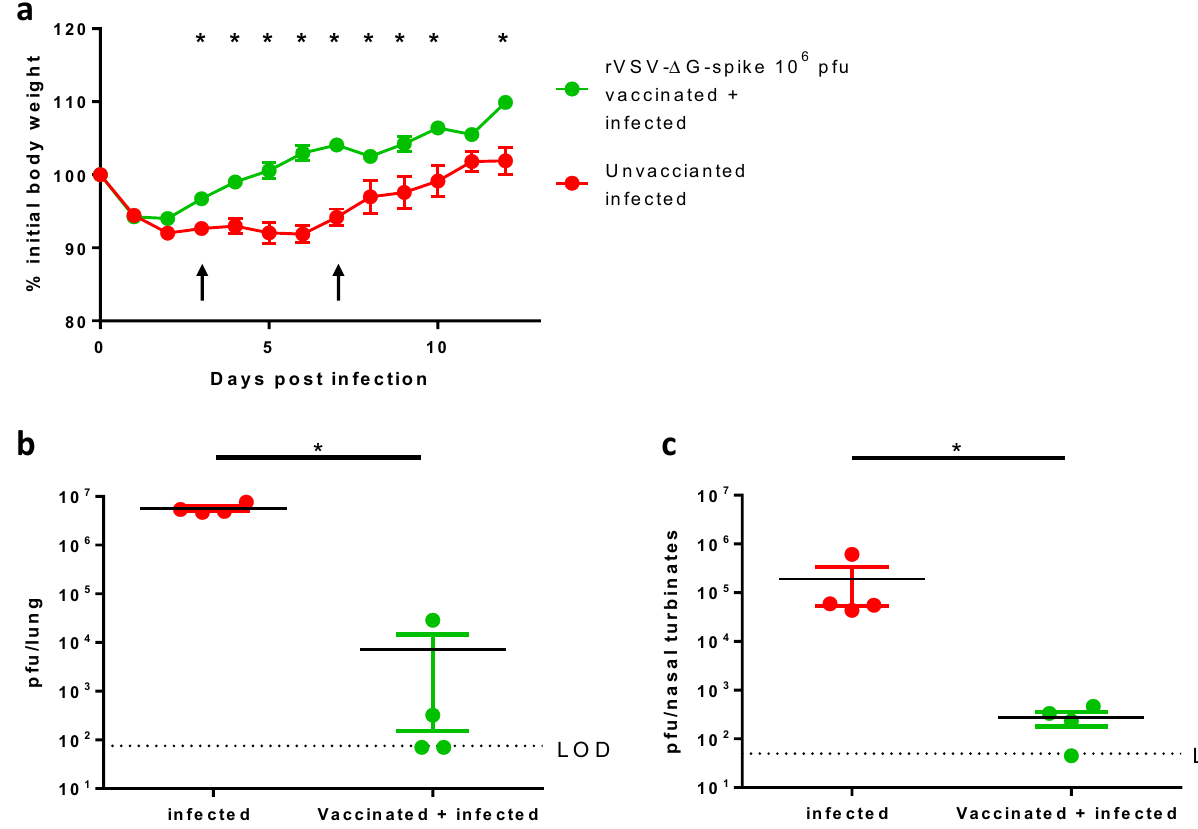
Fig. 6 Viral load analysis in organs of rVSV- Δ G-spike vaccinated hamsters following SARS-CoV-2 challenge. a Body weight changes of SARS-CoV-2 infected hamsters (5 × 10 6 pfu) 25 days post vaccination with 1 × 10 6 pfu, or unvaccinated. Arrows indicate 3 and 7 dpi — hamsters were sacri fi ced. Number of animals per group: days 0 – 3 n = 15, days 4 – 7 n = 7, days 8 – 12 n = 3. Statistical signi fi cance was performed by using two-tailed one unpaired t -test per row, with correction for multiple comparisons using Holm – Sidak method, * p < 0.005. Viral loads in lungs ( b ) and nasal turbinates ( c ) at 3 dpi of hamsters infected with SARS-CoV-2 (5 × 10 6 pfu/hamster, n = 4), and hamsters vaccinated with rVSV- Δ G-spike (10 6 pfu/hamster), followed by infection with SARS-CoV-2 (5 × 10 6 pfu/hamster, n = 4). LOD: 75 pfu/lung, 50 pfu/nasal turbinates. Data for a – c are presented as mean values ± SEM. Signi fi cance analysis for b and c was performed using two-tailed unpaired Mann – Whitney nonparametric test, * p = 0.0286. Source data are provided as a Source Data fi showed average viral titers of 1.9 × 10 5 pfu/nasal turbinates ( n = 4), whereas viral titers in nasal turbinates of vaccinated and infected animals similarly showed a signi fi cant reduction in average viral titers to 2.8 × 10 2 pfu/nasal turbinates ( n = 4) (Fig. 6c). Taken together, a single-dose vaccination of hamsters was able to reduce the viral titer by three orders of magnitude, in both tested organs.